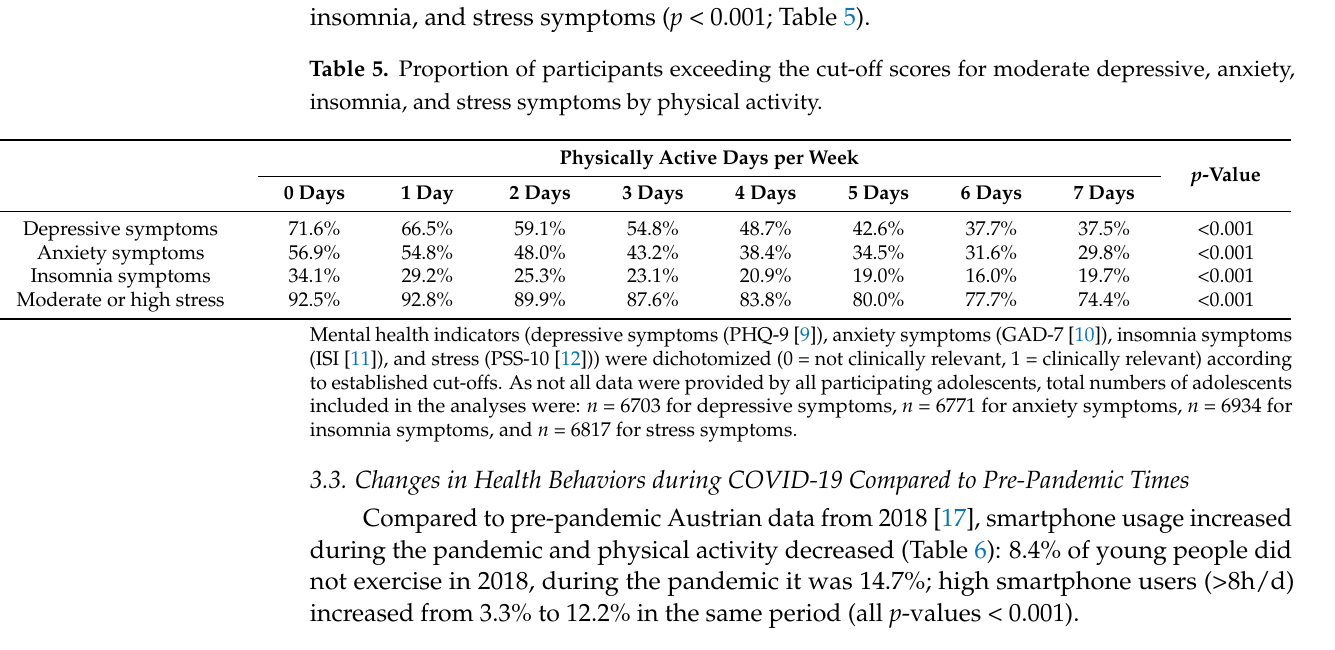
Table 6. Smartphone usage and physical activity in adolescents before the COVID-19 pandemic and during the COVID-19